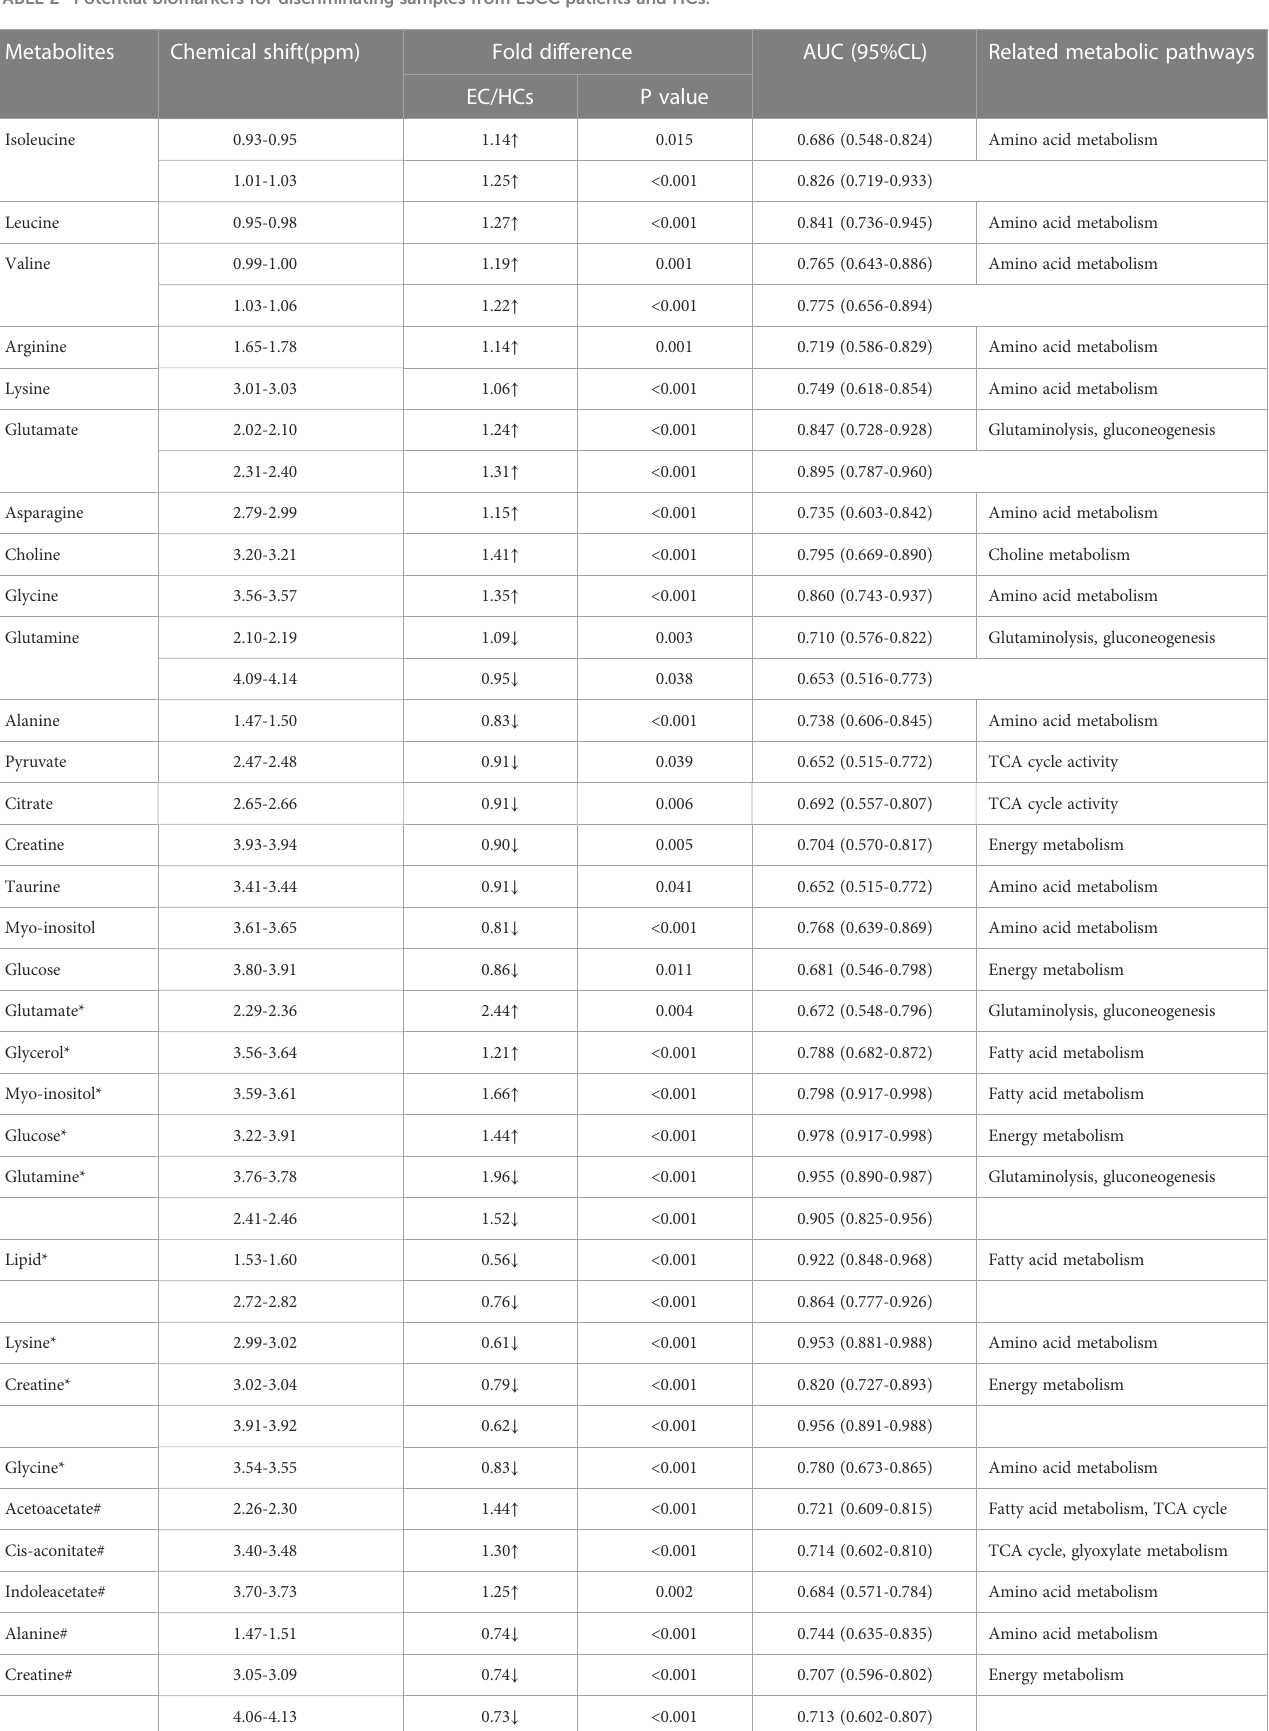
TABLE 2 Potential biomarkers for discriminating samples from ESCC patients and